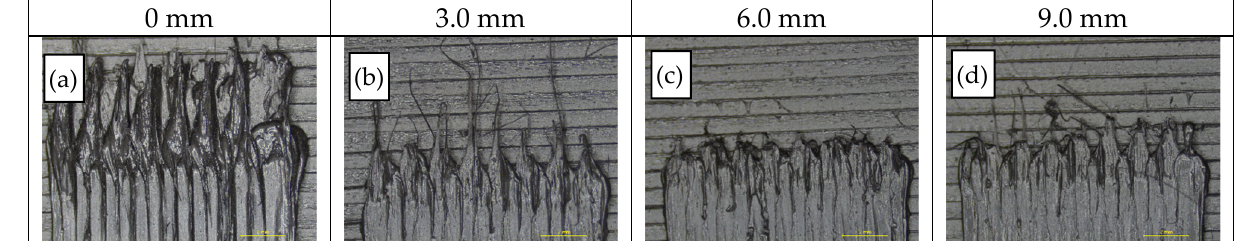
Figure 15. Optical inspection via stereomicroscope (7×) of specimens obtained from varying retraction distances (RD): ( a–d ) RD = 0.0, 3.0, 6.0, 9.0 mm from left to right. In short, the extrusion temperature, printing speed, strand height and width, extrusion multiplier, and retraction distance all have an impact on the processability of FFF, and a combination of the optimized processing parameters is highlighted in Table 4. Table 4. List of 3D printing parameters in the FFF processability assessment for PA12 compound with 15 wt% of GNPs and 1 wt% CNTs.